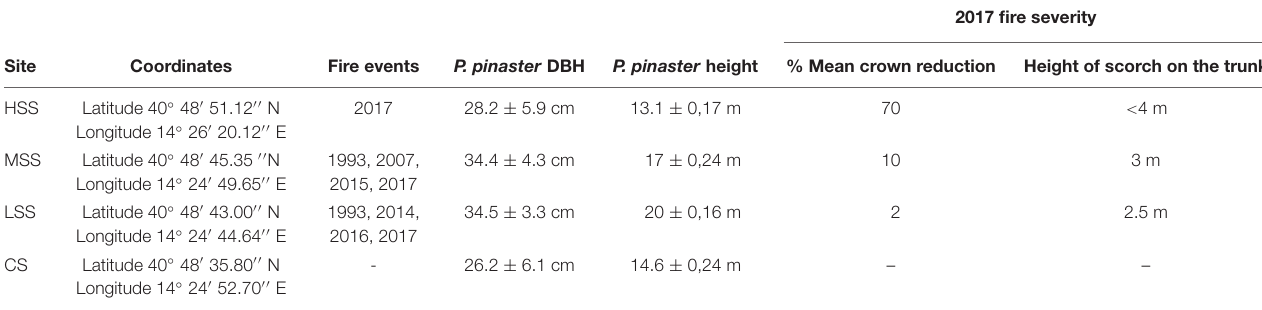
TABLE 1 | Sites coordinates, historical fire events, tree average diameter at breast height (DBH), tree height and severity parameters (percentage of crown reduction, height of scorch on the trunk) of 2017